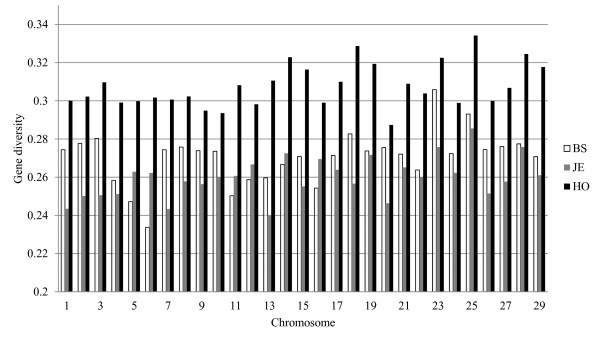
Average gene diversity expressed in terms of observed heterozygosity per chromosome in Brown Swiss (BS = white bar), Jersey (JE = grey bar) and Holstein bulls (HO = black bar).